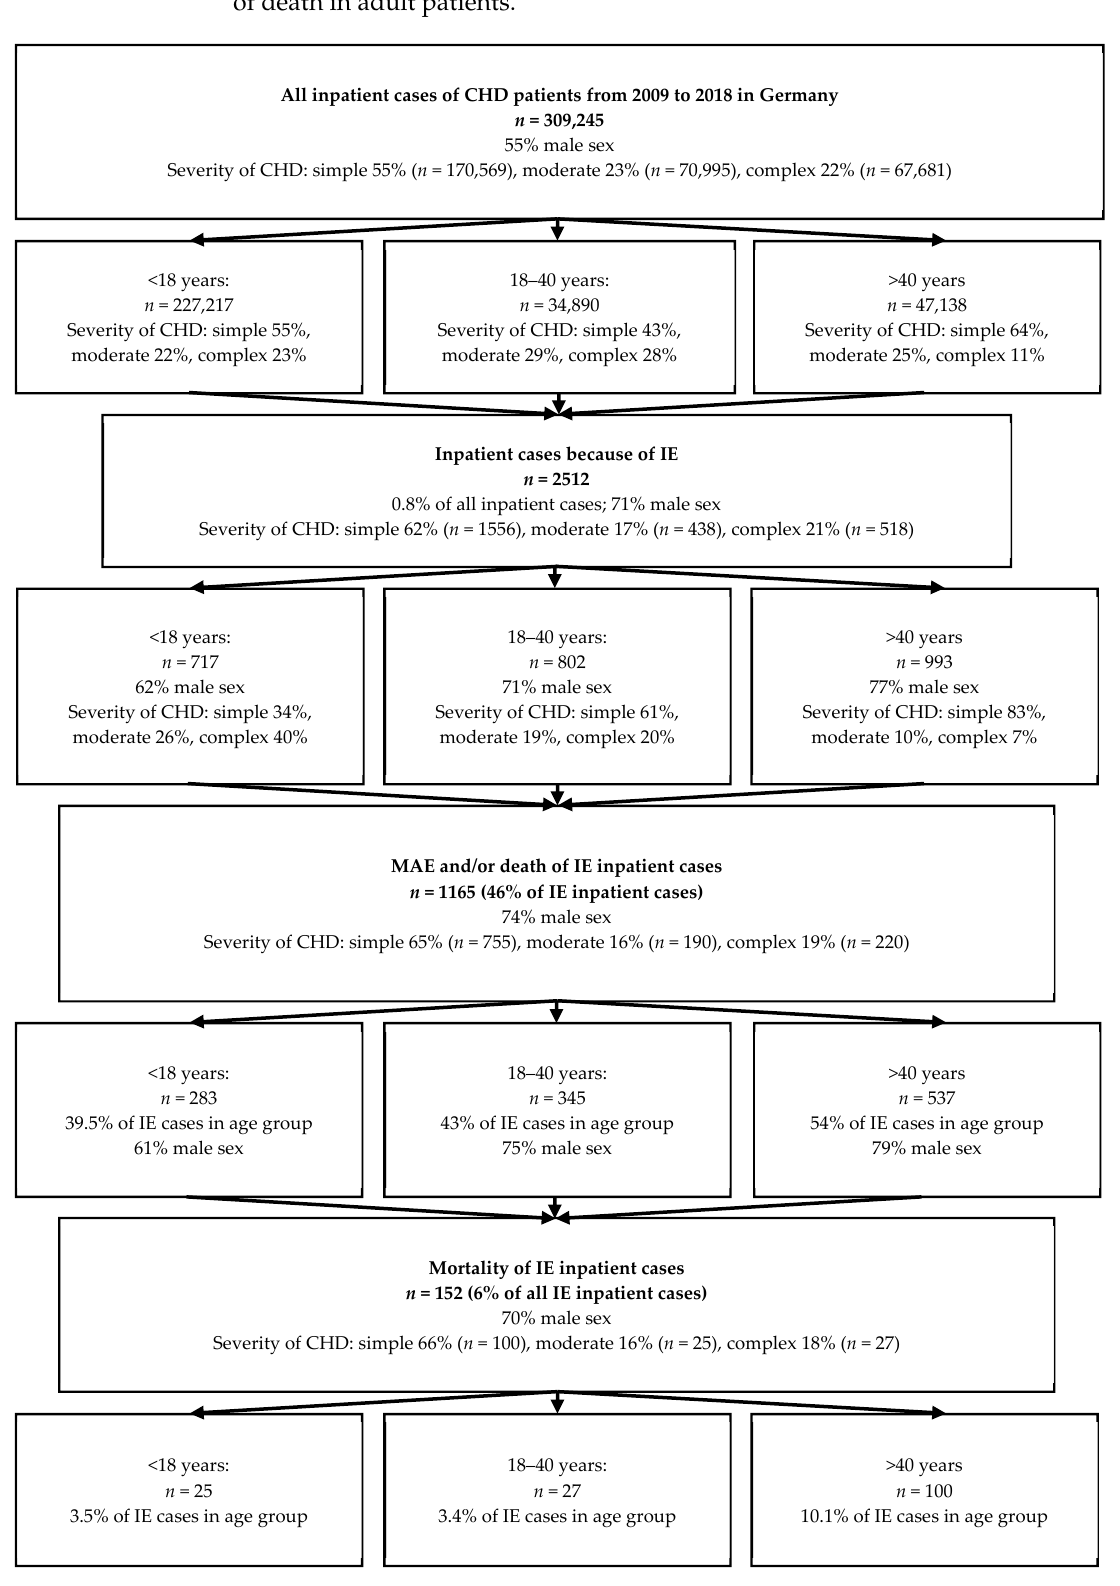
Figure 1. Frequency, Mortality and Major Adverse Outcomes for IE in CHD patients from 2009 to 2018 in Germany. CHD = congenital heart disease; IE = infective endocarditis; MAE = major adverse events.